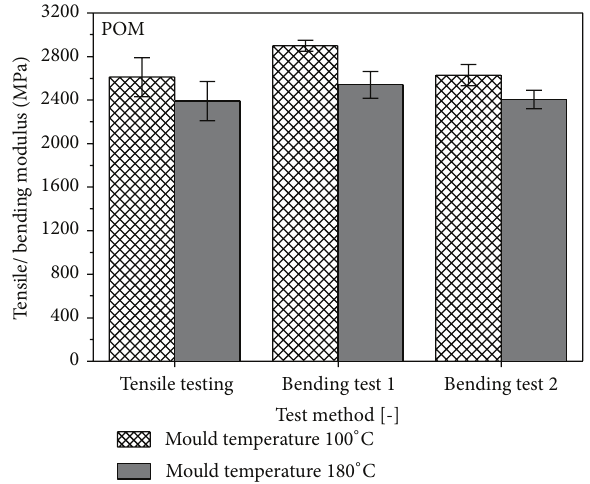
Figure 10: Tensile and bending modulus of the POM specimens.